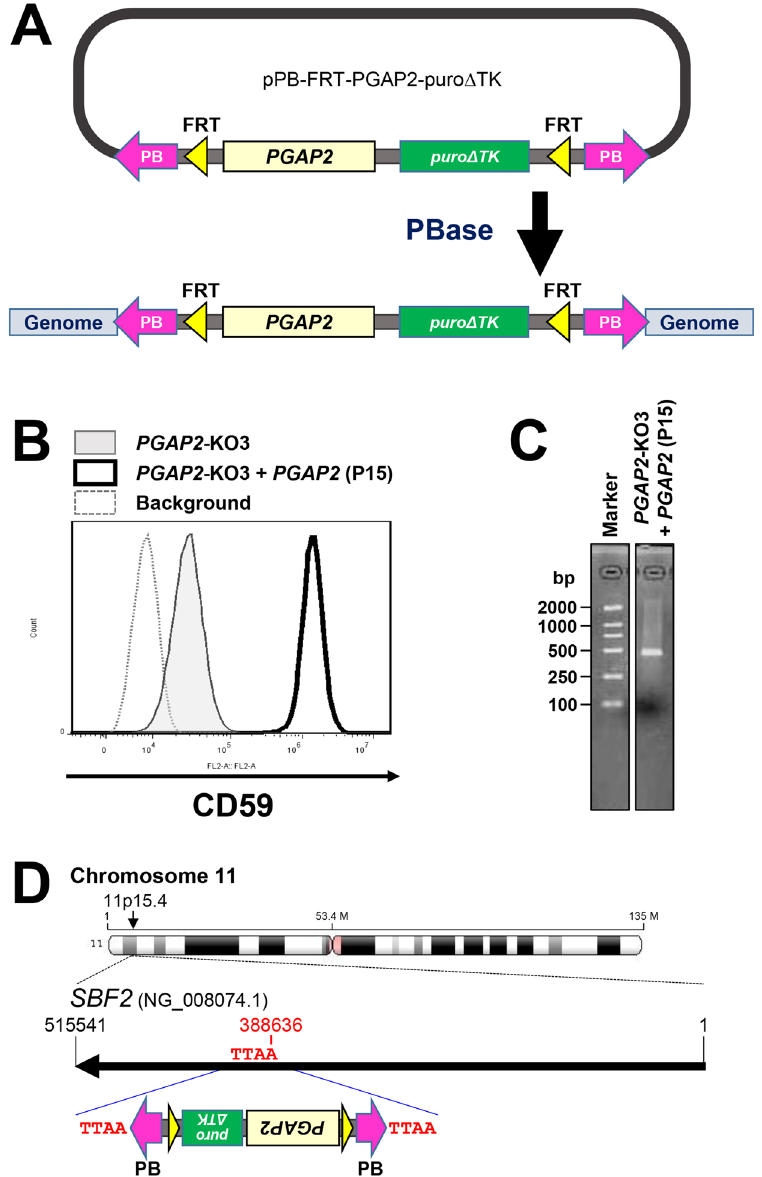
Figure 3. Restoration of CD59 surface expression after PB -mediated rescue of PGAP2 . ( A ) Schematic view of PGAP2 rescue using the PB transposon system. Plasmids containing PGAP2 and puro Δ TK flanked by PB and FRT at both ends were transfected into cells together with a plasmid expressing PBase. After puromycin selection, cells stably expressing PGAP2 were obtained. ( B ) Restoration of surface expression in PGAP2 -KO cells. PGAP2 -KO3 cells were co-transfected with pCMV-hyPBase expressing PB transposase and pPB-FRT- Puro Δ TK-PGAP2 to integrate the PGAP2 gene into the genome. CD59 on the cell surface was detected by flow cytometry. ( C , D ) After genomic DNA was extracted from P15 cells, the PB insertion site and PB copy number were determined in the genome. In P15 cells, only one PB copy band was detected ( C ). The full image of the gel was included in the supplementary information. The PB element was inserted into the intron region of the SBF2 gene region on chromosome 11 ( D